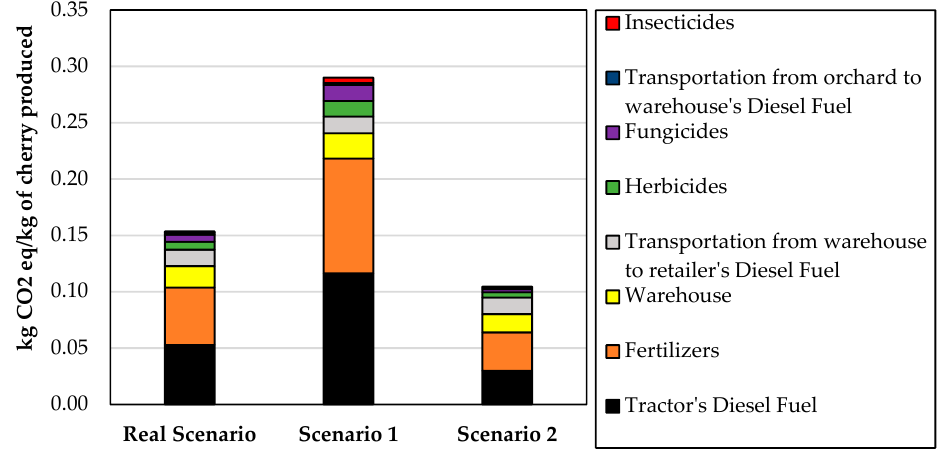
Figure 3. The global warming indicator for the FU of 1 kg of produced cherry for the real and test scenarios, considering the insecticides, transportation from the orchard to the warehouse’s diesel fuel, herbicides, transportation from the warehouse to the retailer’s diesel fuel, fertilizers and tractor’s diesel fuel environmental impacts.